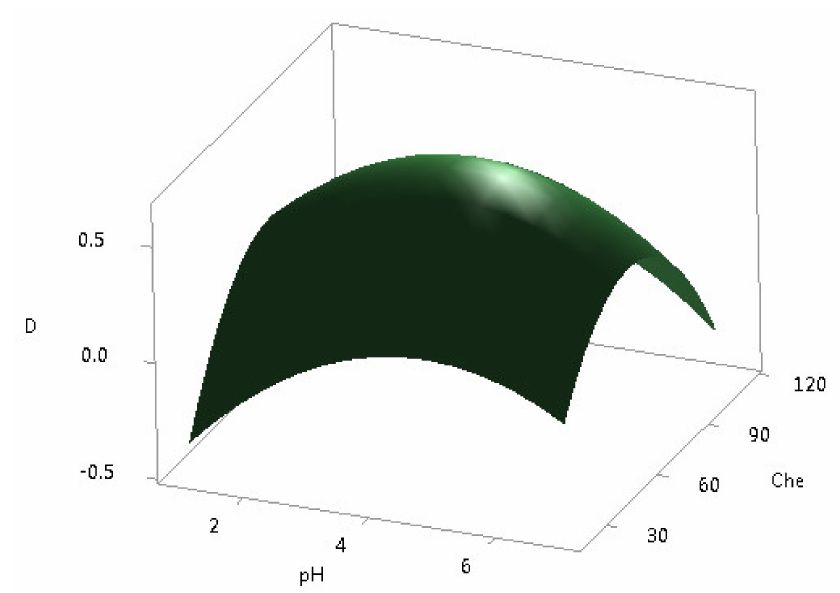
Figure 4. Response surface plot for DSPME optimization.